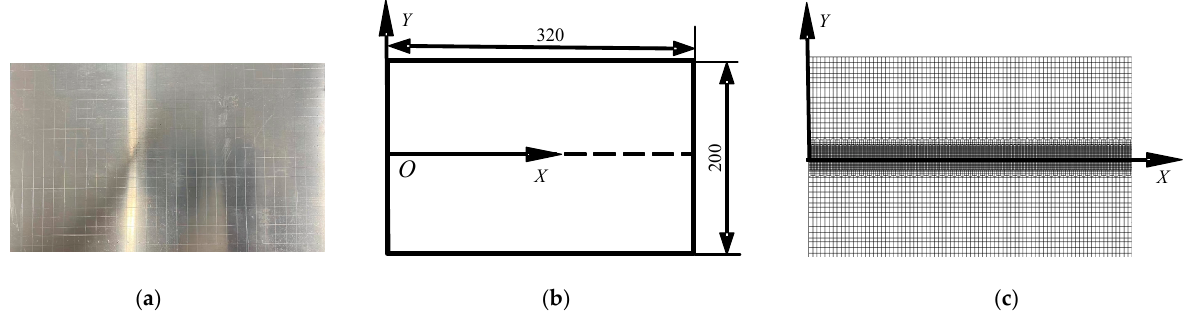
Figure 3. Welding model diagram of an aluminum alloy sheet: ( a ) specimen; ( b ) geometric model; ( c ) finite element model.